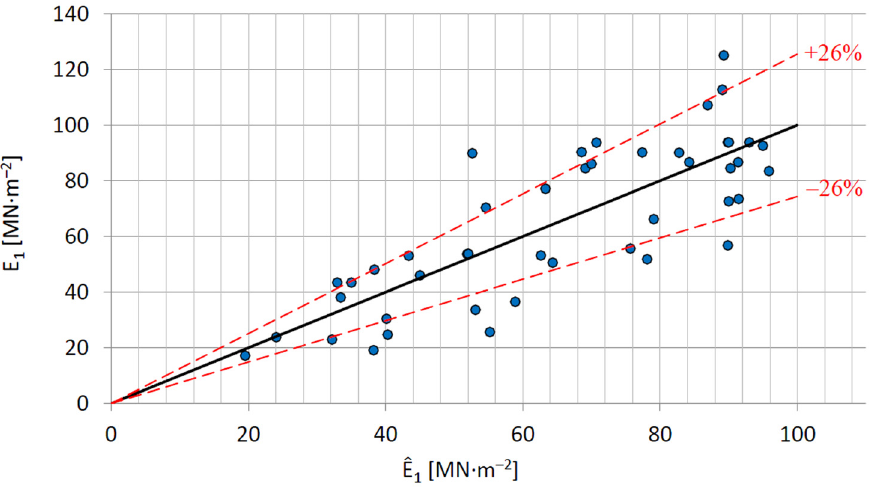
Figure 5. Comparison of the values of the deformation modulus after the first loading cycle from the tests (E 1 ) with the predicted values (Ê 1 ) by the proposed linear regression model (Ê 1 = 0.11 + 1.60E vd ), together with the cones of relative error (RE). Table 4. Dependencies of dynamic deformation modulus E vd and ratio s/v (LFWD Zorn, type ZFG 3000 GPS, 300 mm diameter load plate, 10 kg drop weight) on primary deformation modulus E 1 , tested with static load plate—complex regression (E 1 = f(E vd , s/v)).